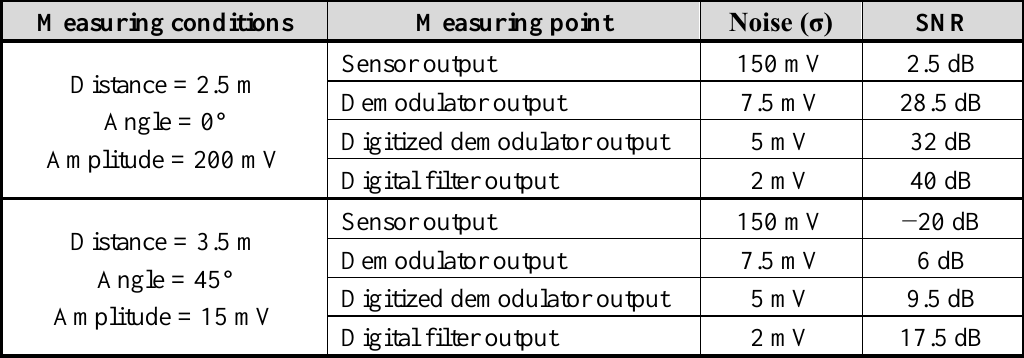
Table 3. SNR levels in different stages after